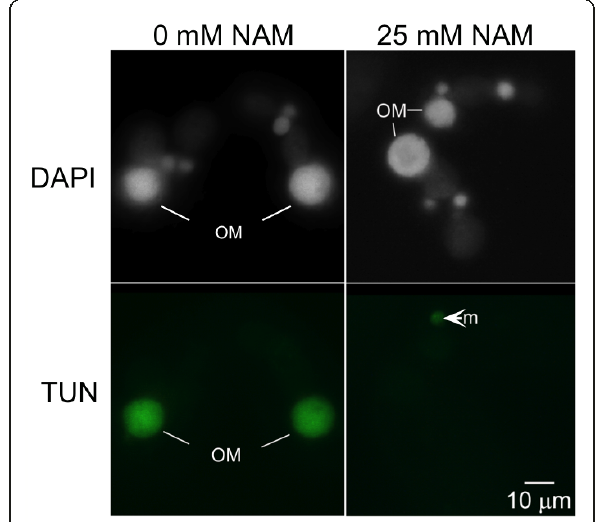
Figure 3 Nicotinamide prevents degradation of the parental macronucleus during conjugation . Just prior to mixing, cells were exposed to either 0 mM or 25 mM nicotinamide (NAM). At 10 hrs into conjugation (post-mixing), the cells were fixed in 2% paraformaldehyde, exposed to terminal deoxynucleotidyl transferase dUTP nick end labeling (TUNEL) reagent to assay for degraded DNA, and stained with DAPI prior to imaging. In cells exposed to NAM, the old macronuclei “ OM ” were TUNEL negative, while the OM of nontreated cells were TUNEL positive (green). “ m ” ,